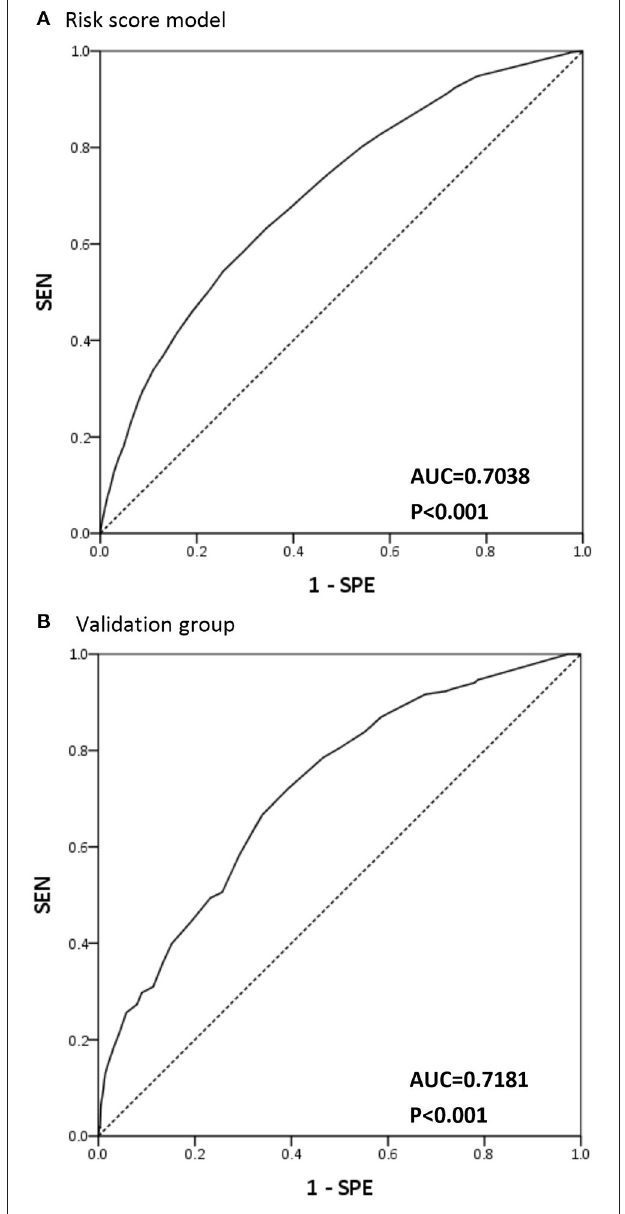
FIGURE 3 | AUC curve for readmission risk score model and validation group. (A) Area under the receiver operator curve (AUC) for risk score model in predict coronary care unit readmission. (B) AUC for risk score model in predict coronary care unit readmission in validation